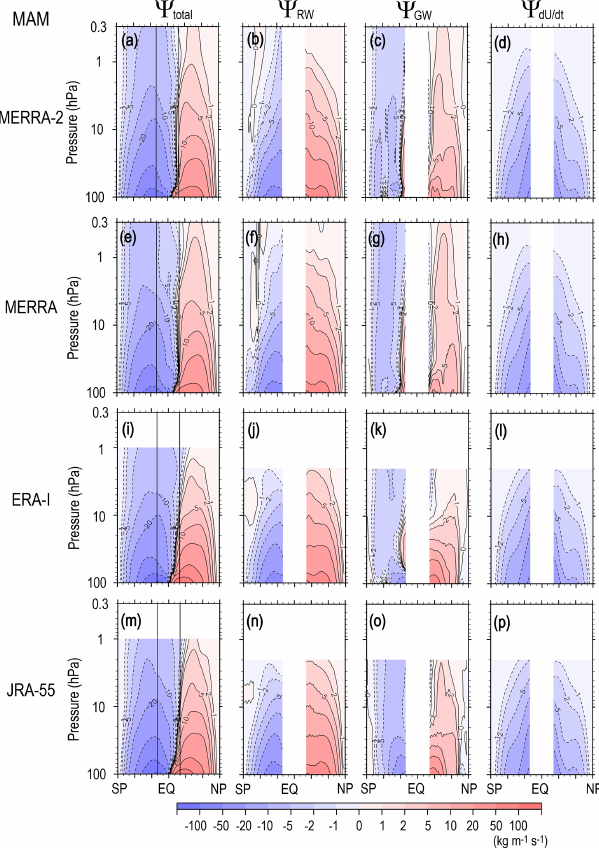
Figure 7. The same as Fig. 6 but for JJA. Figure 8. The same as Fig. 6 but for